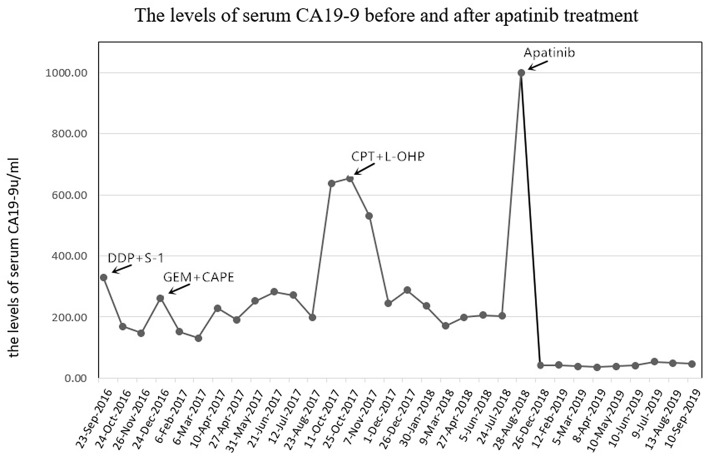
The levels of serum CA19-9 (normal range, 0–22 U/mL) before and after apatinib treatment. CA19-9, cancer antigen 19-9; DDP, cisplatin; GEM, gemcitabine; CAPE, capecitabine; CPT-11, irinotecan; L-OHP, oxaliplatin.